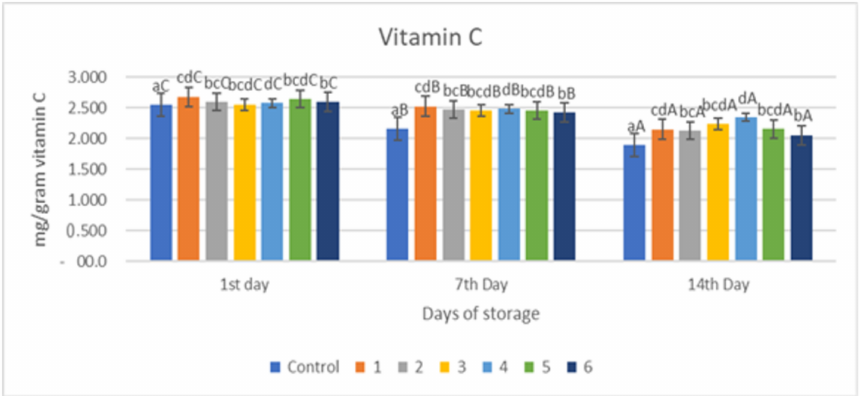
Figure 3. Total Vitamin C of red chili during storage. a–d non-capital letters show the differ- ence between the sample ( p < 0.05). A–C capital letters show the difference between the day of storage ( p < 0.05). Control: Uncoated Sample; 1: Gelatin75%-Pectin25%-Garlic Essential Oil2%; 2: Gelatin75%-Pectin25%-Garlic Essential Oil Oil3%; 3: Gelatin50%-Pectin50%-Garlic Essential Oil Oil2%; 4: Gelatin50%-Pectin50%-Garlic Essential Oil Oil3%; 5: Gelatin25%-Pectin75%-Garlic Essential Oil Oil2%; 6: Gelatin25%-Pectin75%-Garlic Essential Oil